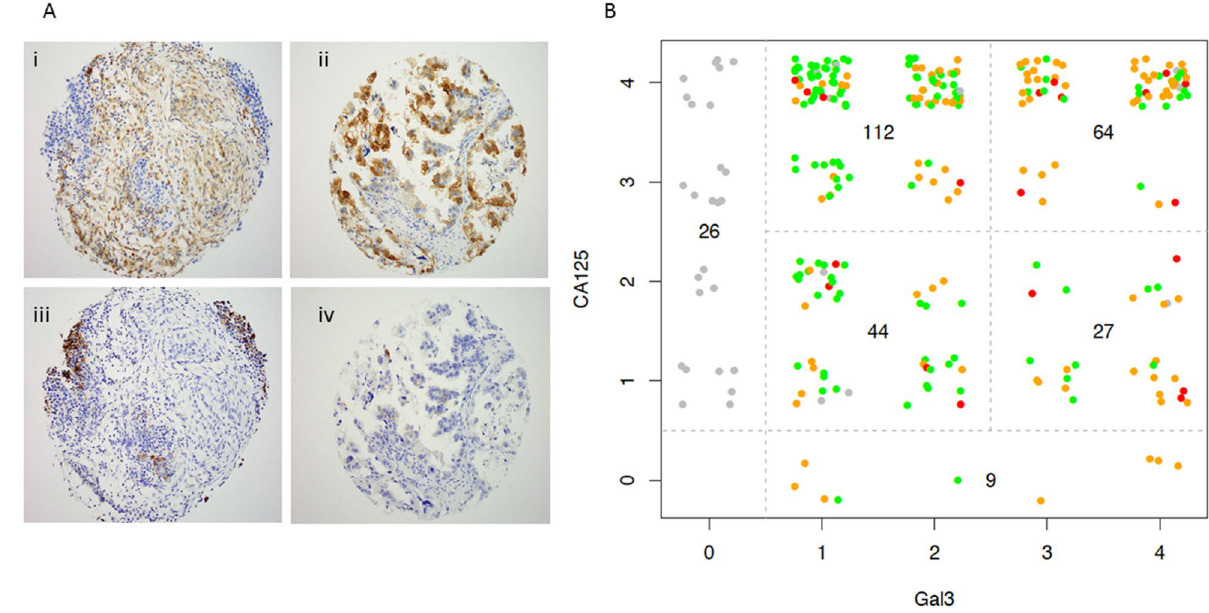
Figure 1. Expression of LGALS3 and CA125 (MUC16) in human ovarian cancers. Three anonymized human tissue microarrays were constructed by collecting 1–3 cores from paraffin embedded, fixed blocks, as previously described 27 . ( A ) Examples of human tumor cores stained for CA125 (panel i) and Gal3 (panel ii). Examples of core that did not stain for CA125 (panel iv) and tumor that did not stain for Gal3 (panel iii). ( B ) Each core was qualitatively scored for prevalence of CA125 and Gal3 positive cells (0 = < 5%, 1 + = 5–25%; 2 + = 25–50%; 3 + = 50–75% and 4 + = > 75%. The intensity for Gal3 was separately scored as low, medium and high (represented by green, orange and red dots respectively). All cores were independently scored by a blinded reference pathologist